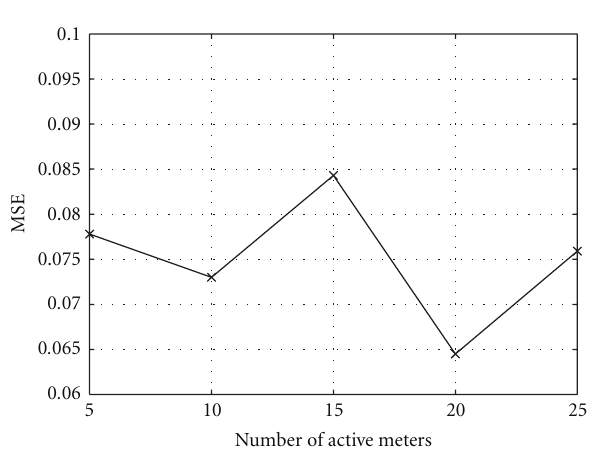
Figure 12: MSE achieved by CSKF for di ff erent number of active